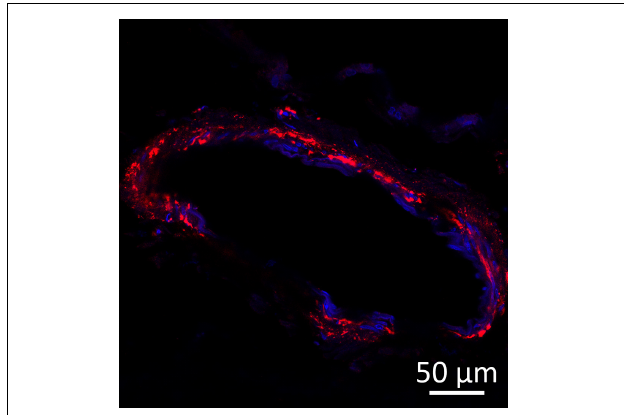
FIGURE 3 | Amyloid beta (red) detected by immunofluorescence staining in the wall of a leptomeningeal blood vessel in the frontal cortex from a 15-years-old Pit Bull Terrier. Nuclei were counterstained with DAPI (blue). The antibody employed is the same as in Figure 2 . Original microphotograph made by the authors.